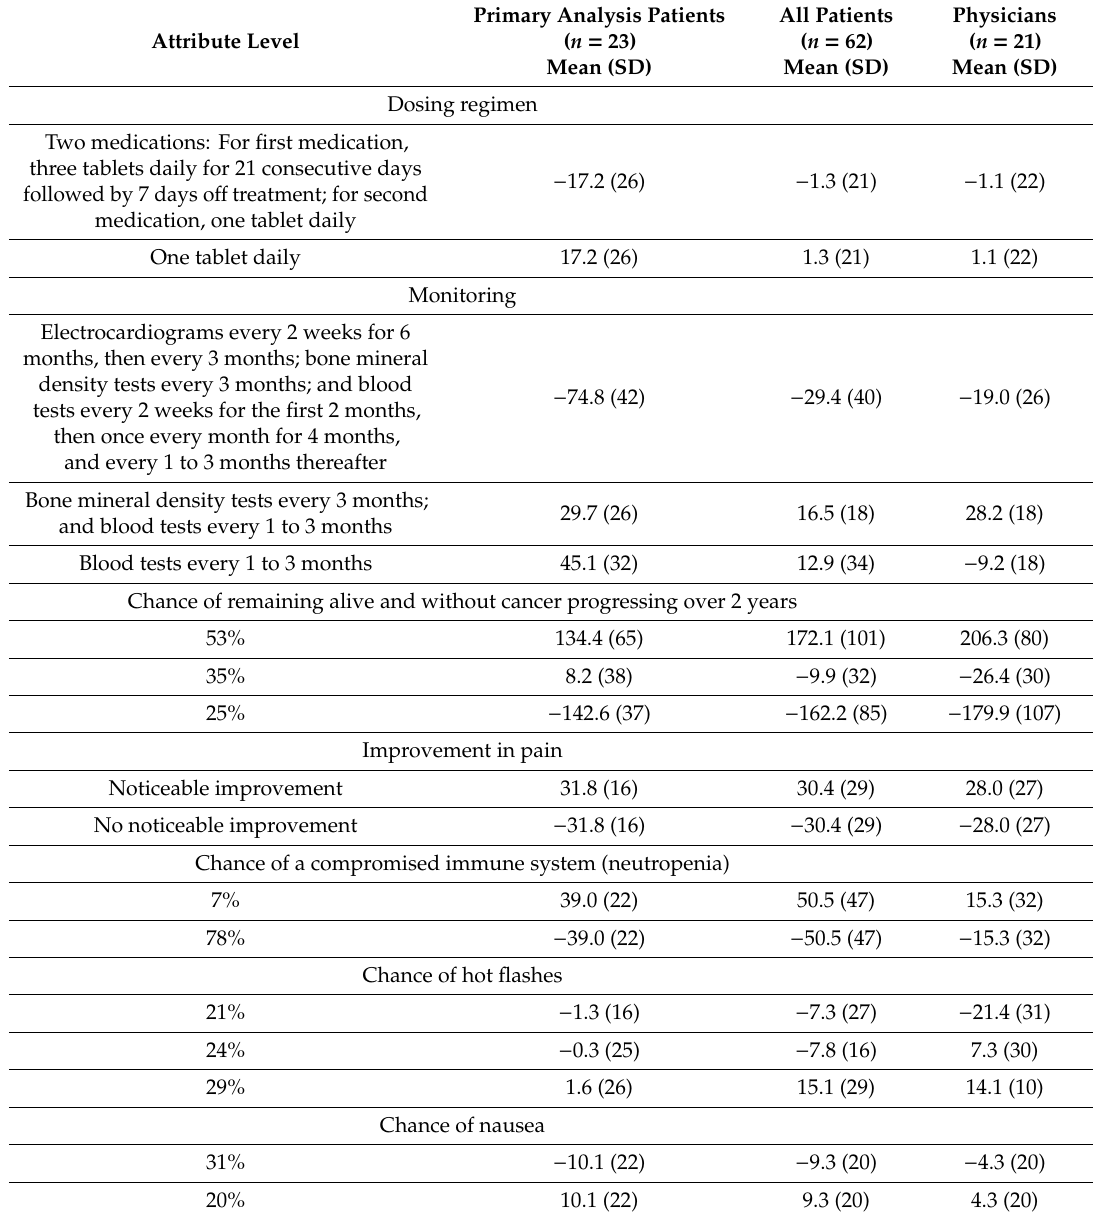
Table 4. Attribute-level preference